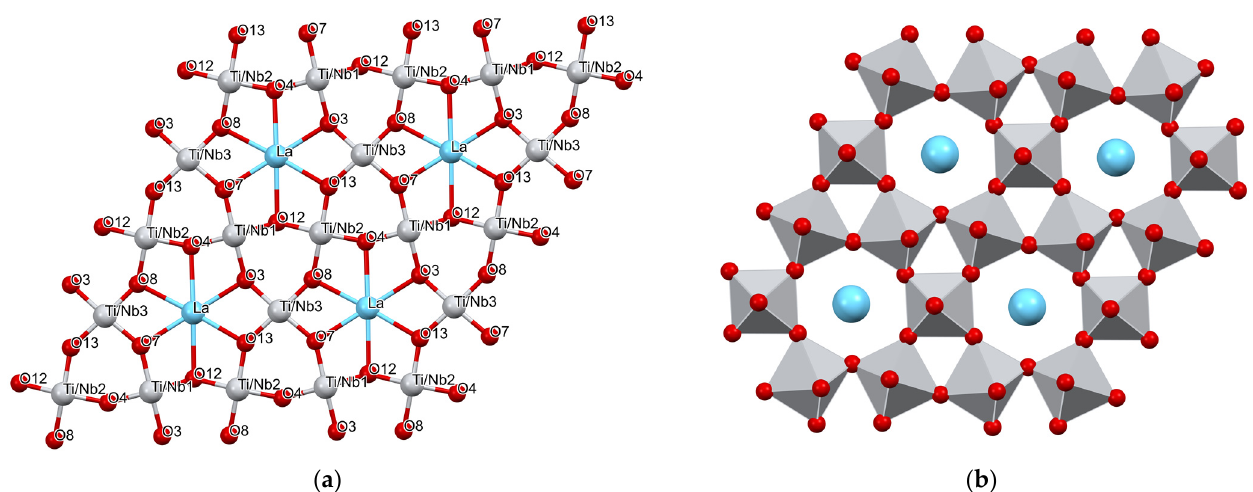
Figure 5. The structure of the sublayer containing La, Ti/Nb 1,2,3 and O3, O4, O7, O8, O12, O13 sites. The pseudo-hexagonal arrangement in this sublayer is clearly visible: ( a ) Ball and stick model with atom labelling; ( b ) Polyhedral representation.